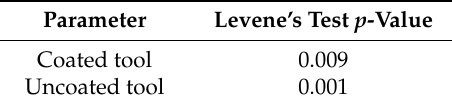
Table 10. The test for the equal equation.